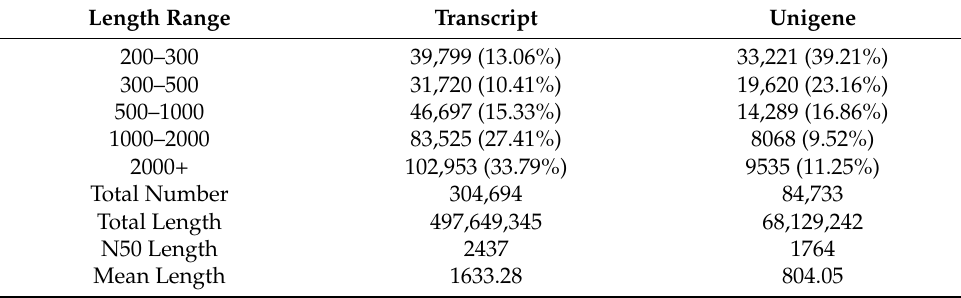
Table 1. Results of the hybrid poplar xylem transcriptome assembly.